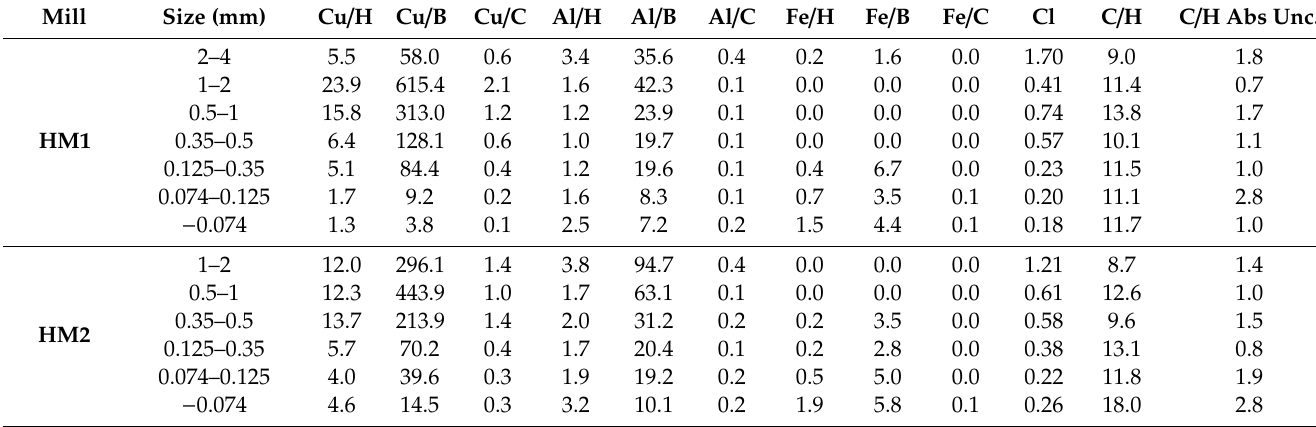
Table 4. Metal / light element ratios to compare the deportment / concentration in each size fraction analyzed. In the far right column, the C-H ratio is also given along with the corresponding calculated absolute